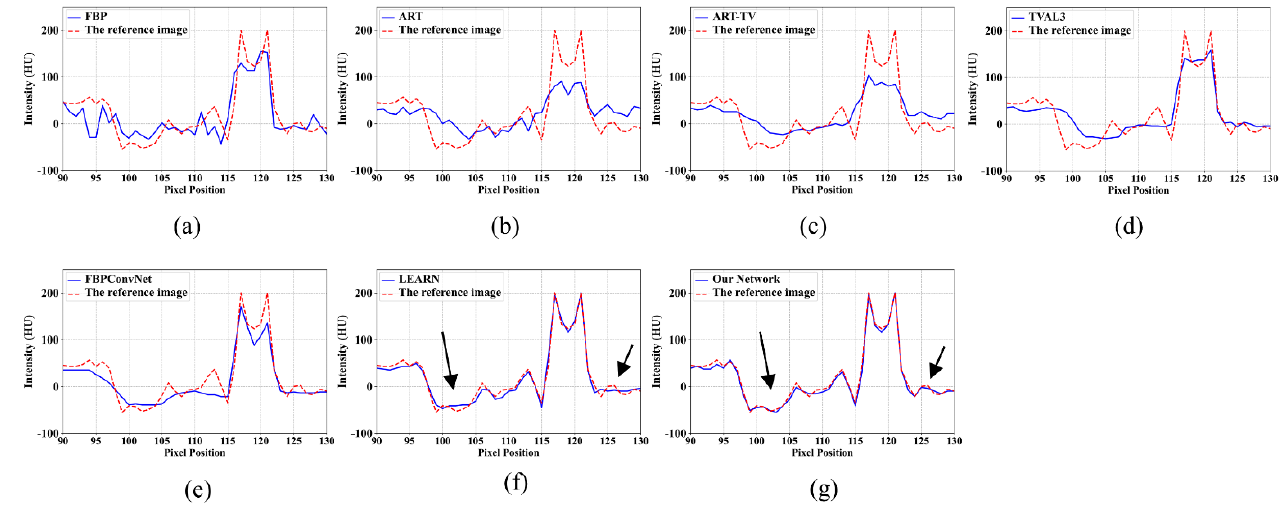
Figure 4. Horizontal profiles along the blue line shown in Figure 3a of the reference image versus the images reconstructed (from 32 views) using ( a ) FBP, ( b ) ART, ( c ) ART-TV, ( d ) TVAL3, ( e ) FBPConvNet, ( f ) LEARN, and ( g ) our network. The differences between our network and the LEARN method are marked by black arrows.